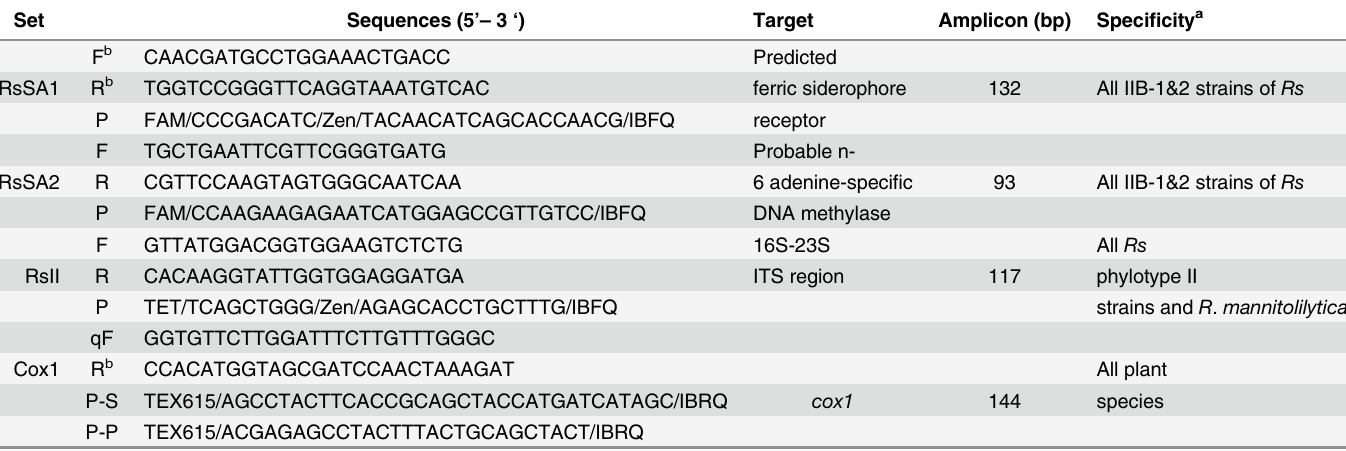
Table 2. Primers and probes used in this